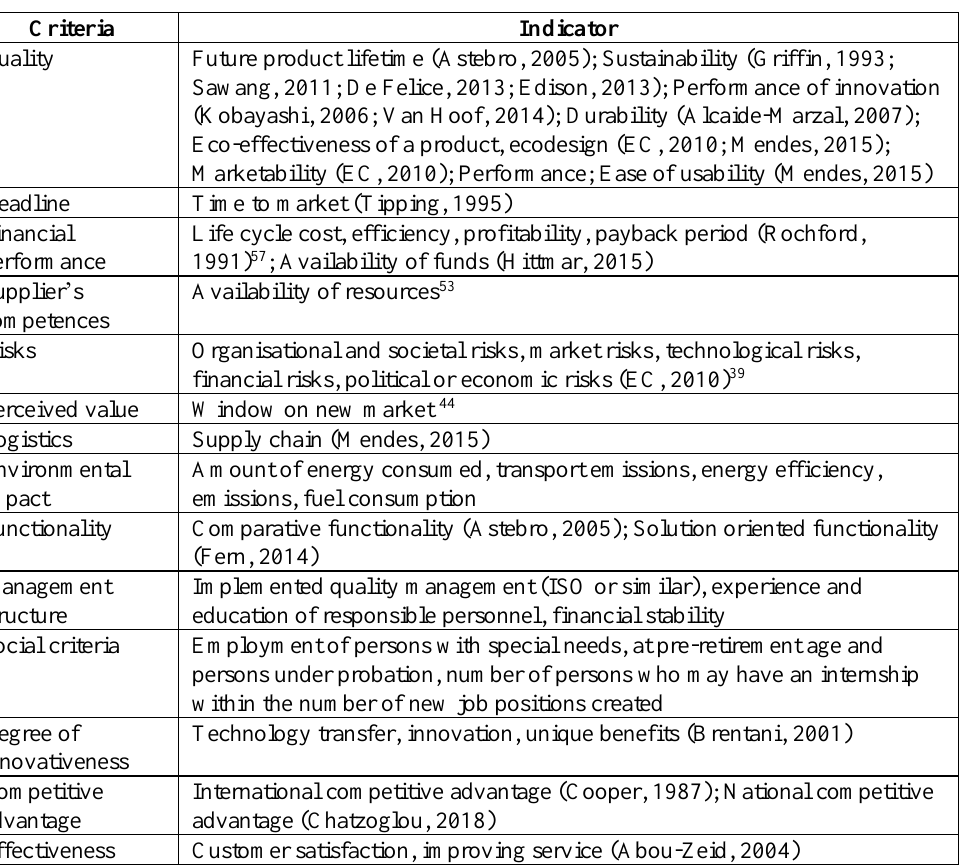
Table 1. Criteria and their Indicators for Evaluation of Innovation Proposals (created by the